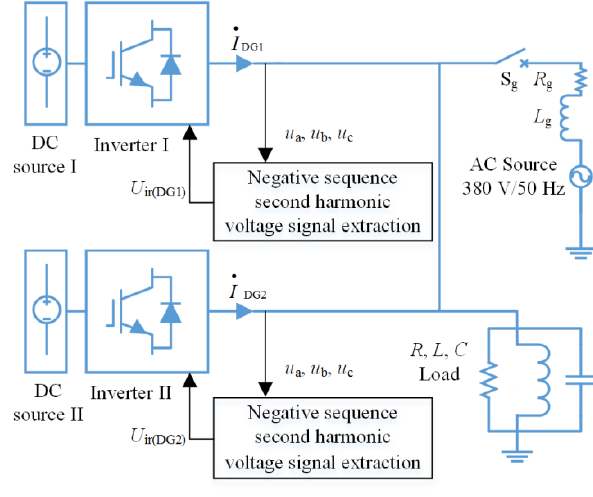
Table 1. Parameters used in the simulation.